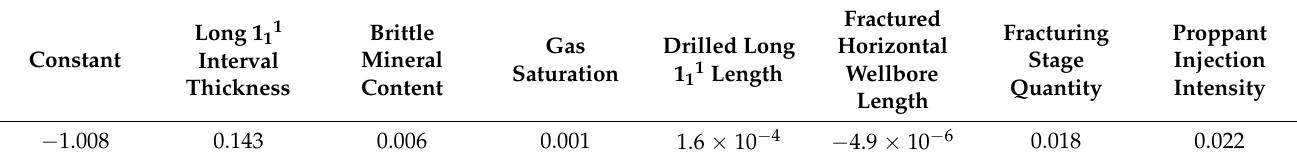
Table 5. Results of the MLR calculation.